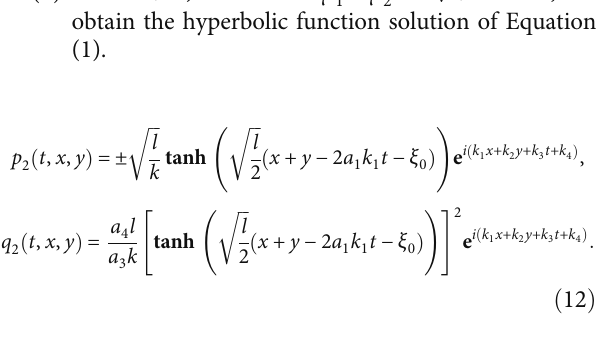
ð t , x , y Þ with a 4